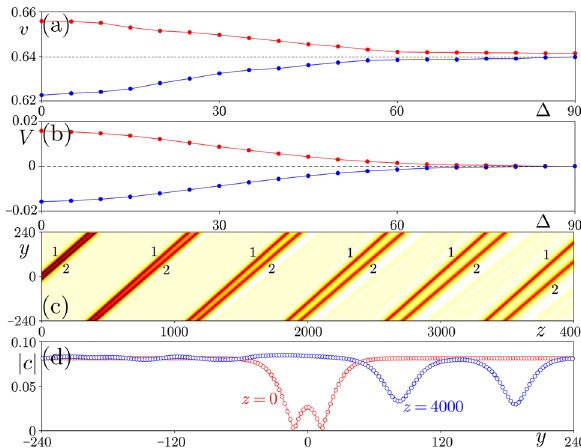
Figure6: RepulsiveinteractionoftwodarkvalleyHalledgesolitons. (a) Asymptotic velocities of two interacting dark solitons versus initial separation Δ between them, based on Eq. (1). (b) Asymptotic velocities of two interacting one-dimensional dark solitons governed by the envelope Eq. (3). (c) Evolution of projections c with distance for initial separation of Δ = 25. (c) Projections c at z = 0 (red curve) and z = 4000 (blue fi nite integration window several times, we use numbers 1 and 2 to distinguish two solitons. One can see that not only does separation between two solitons increases indicating on their different asymptotic velocities but also solitons gradually become gray. This is especially obvious from the comparison of projections at z = 0 and z = 4000 in Figure 6(d). Therefore, the valley Hall system supports not only dark states remaining quiescent in the coordinate frame Y = y − v s z moving with the group velocity v s = − b ′ of the linear edge state with selected momentum k but also gray states nested in the same Bloch wave, but moving with respect to it at nonzero velocity, obviously determining soliton grayness.